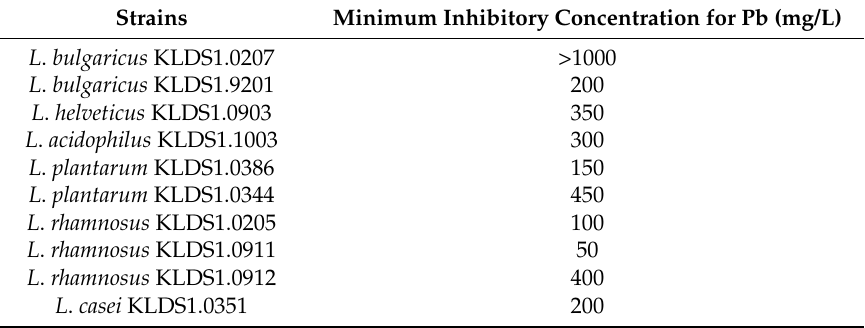
Table 2. Pb tolerance of the tested LAB strains.